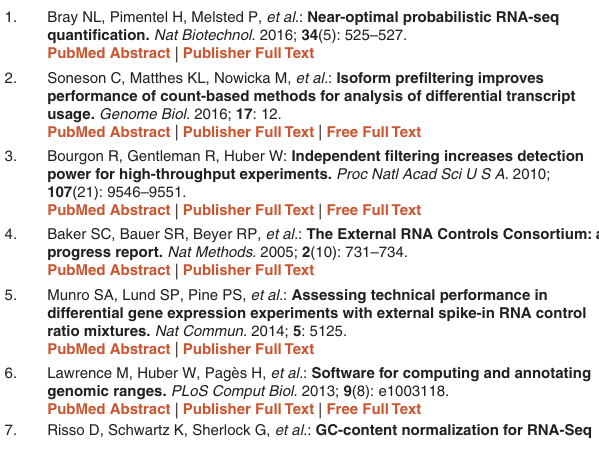
Supplementary Table 2: Data variation with non-matching Kallisto versions. Variation of mean differences between non-matching Kallisto versions and a randomly selected run previously generated (Supplementary Table 1). The rows are samples run using version 0.43.0, the columns are runs using version 0.43.1. Click here to access the data. Supplementary Table 3: Annotation runtime. System runtime for full annotation of a merged KallistoExperiment (seconds). The columns represent system runtime, the Elapsed Time is the total runtime. Click here to access the data. Supplementary Table 4: KallistoExperiment formation runtime. System runtime for the creation of a merged KallistoExperiment (seconds). The columns are similar to Supplementary Table 3. Click here to access the data. Supplementary Figure S1: Arkas-Quantification Web-Style user interface. The input field for A ) Arkas-Quantification and B ) Arkas- Analysis demonstrating SRA re-quantification. The control and comparison samples were obtained using BaseSpace SRA Import application, and were input into the Arkas pipeline.